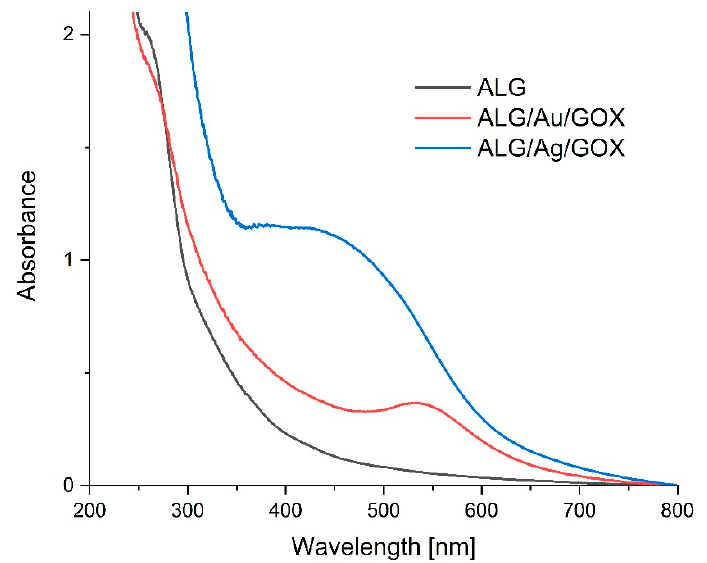
Figure 4. UV–vis spectra of ALG (black line), ALG/Au/GOX (red line) and ALG/Ag/GOX (blue